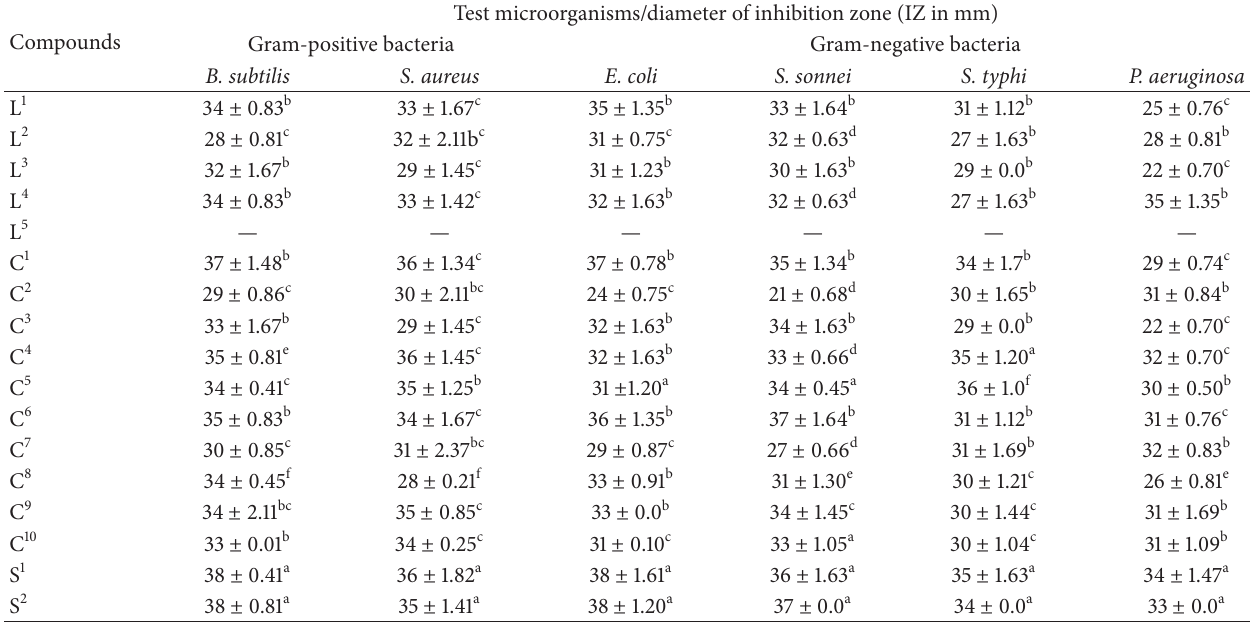
Table 2: In vitro antibacterial activity of ligands (L 1 –L 5 ) and their metal(II) complexes. Test microorganisms/diameter of inhibition zone (IZ in mm) Compounds Gram-positive bacteria